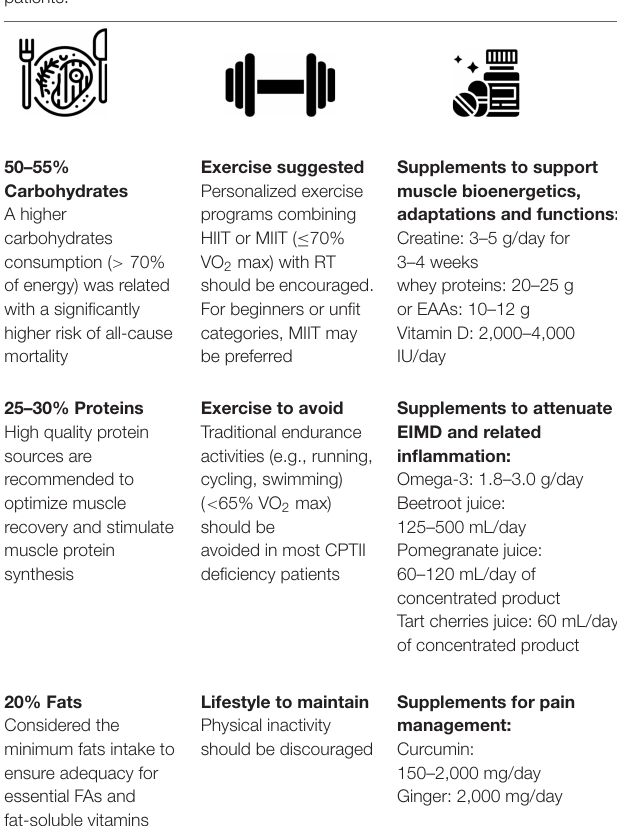
TABLE 1 | Summary of innovative potential treatments for CPTII deficiency patients.